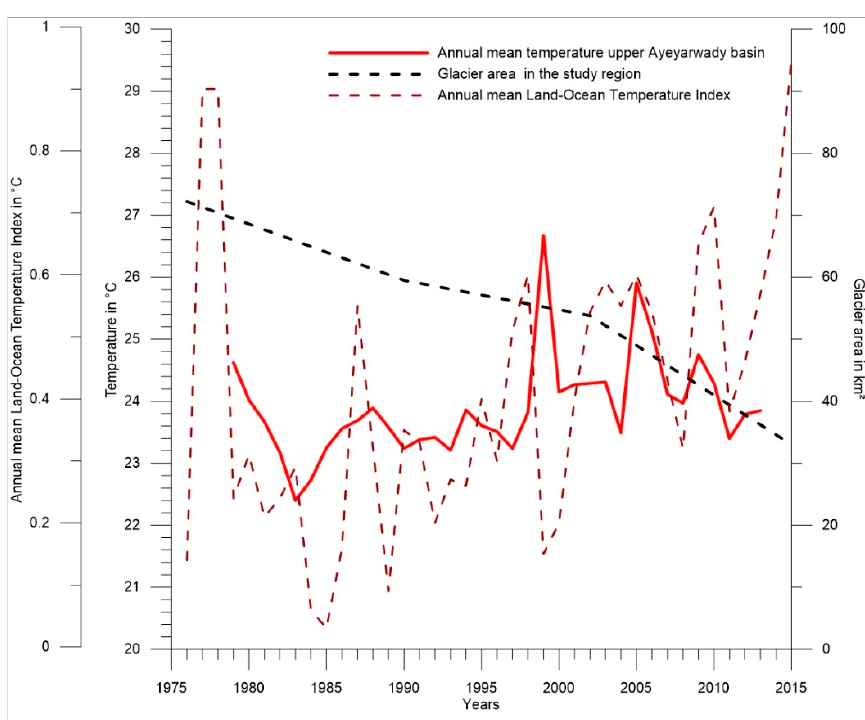
Figure 6. Glacier and air temperature changes between 1976 and 2015 in the study region (dashed black and solid red line) compared with the annual mean land–ocean temperature index (dashed red line) for the northern hemisphere (equator—24° N). The base period is 1951–1980 [31,32].